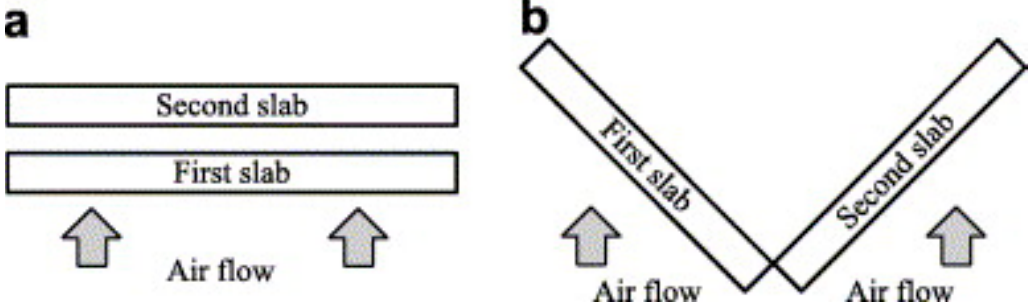
Figure 2. Configurations of the micro-channel heat exchanger slabs: ( a ) Double layer parallel-aligned shape and ( b ) Single layer-V shape. Reproduced with permission from [22]. Elsevier, 2007.